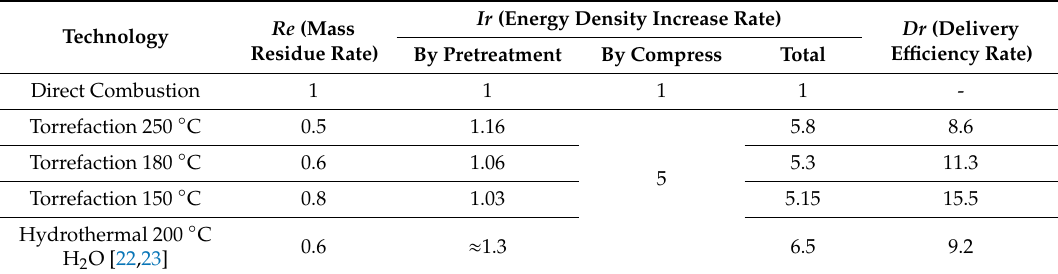
Table 6. Mass residue rate and energy density increase rate of di ff erent technologies.